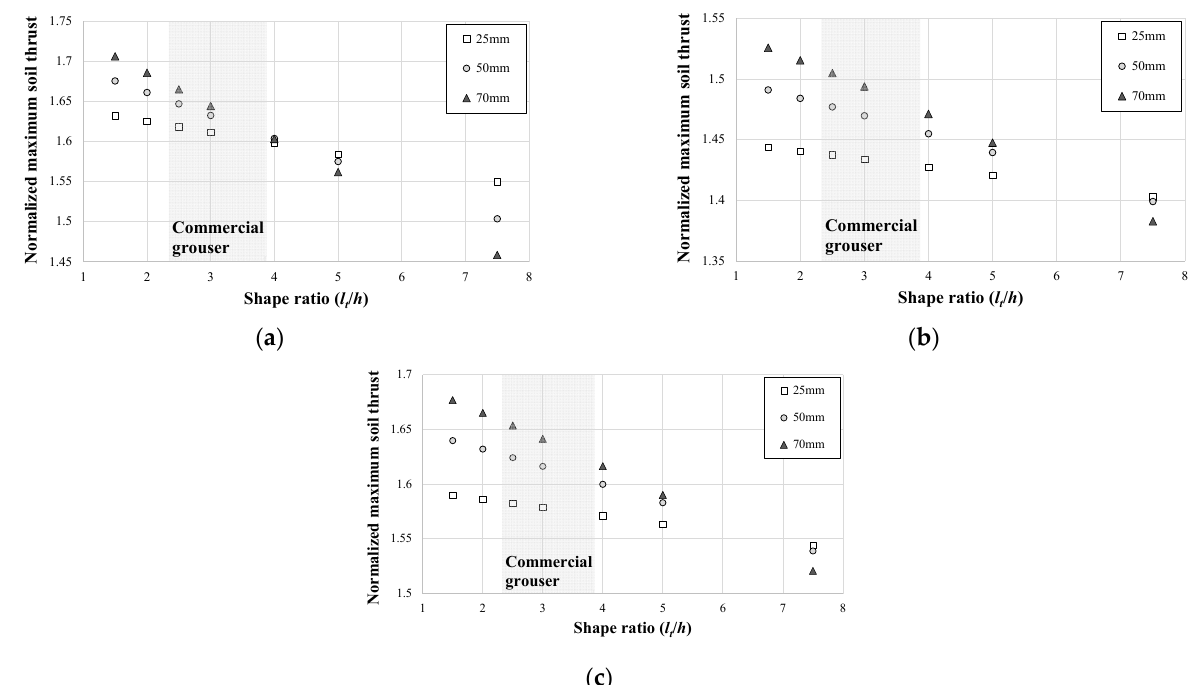
Figure 12. Normalized maximum soil thrust and shape ratio relationships of EC145E: ( a ) hardening behavior, ( b ) softening behavior and ( c ) hump behavior.